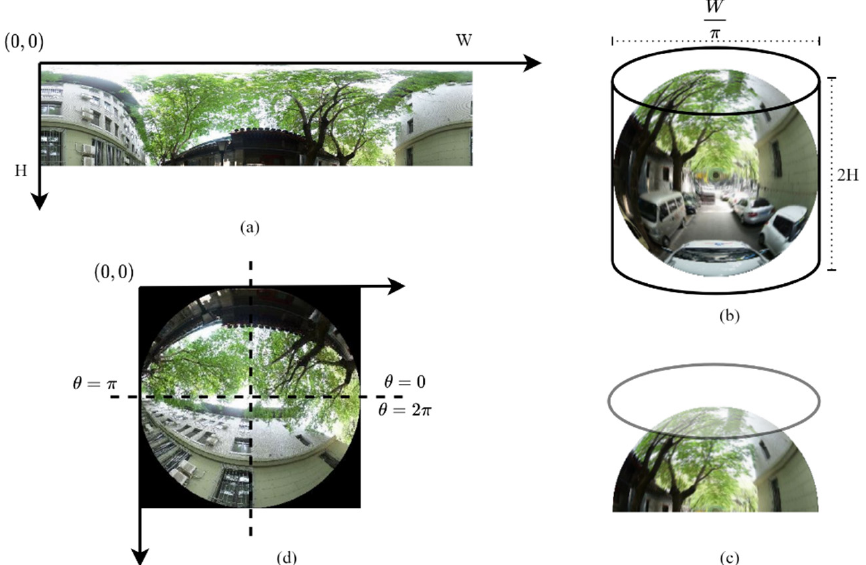
Figure 4. Transformation of cylindrical panoramic image to azimuthal fisheye image. ( a ) Top half of panorama image. ( b ) Schematic diagram of cylindrical projection. ( c ) Schematic diagram of azimuthal projection. ( d ) Fisheye image based on azimuth projection.